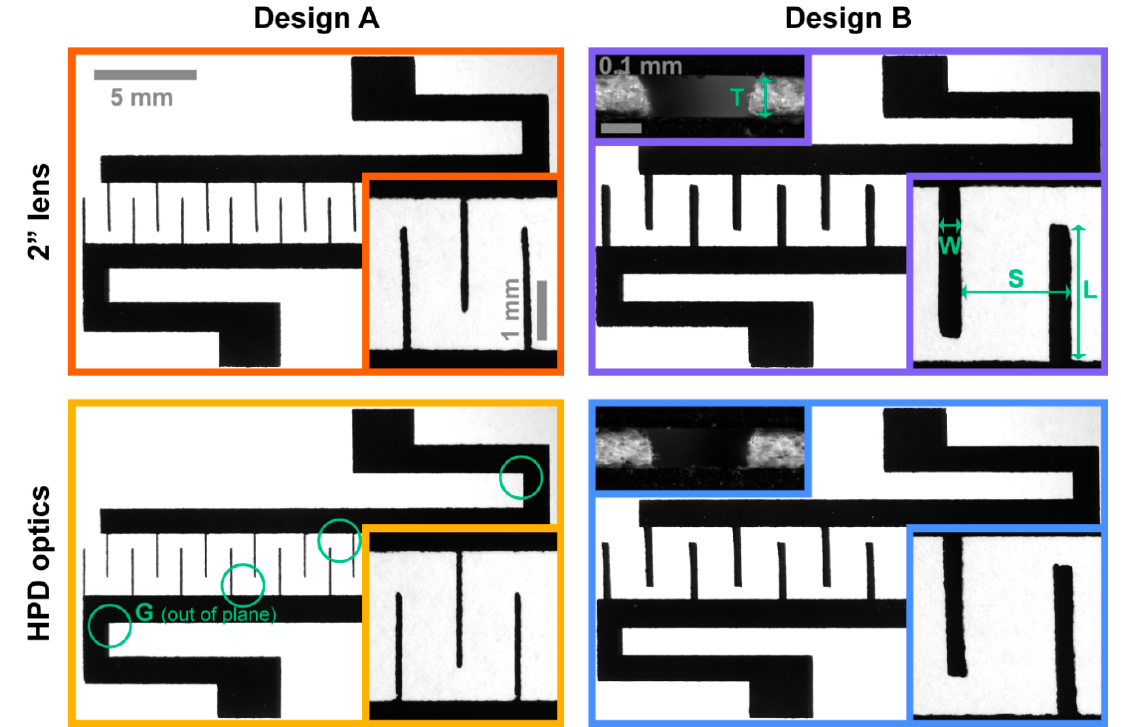
Figure 2. Microscopy images of exemplary laser-cut shadow masks in Whatman Grade 50 quantitative filter paper of both Designs (A: left ; B: right ), utilizing either of the available lenses (2”: top; HPD: bottom). The square insets show electrode finger details (top right further indicating the analyzed dimensions; cf. Table 2). For Design B, we additionally show insets of razor-blade-cut mask cross-sections of a single electrode finger, sandwiched between two glass slides, indicating the mask thickness T (cf. Table 3). Scale bars are conserved across all four conditions. The green circles (bottom left) show selected measurement locations for the out-of-plane gap G between the mask and the underlying substrate (Figure 3 and Section 3.3). The border colors correspond to those used for the data in Figure 4.